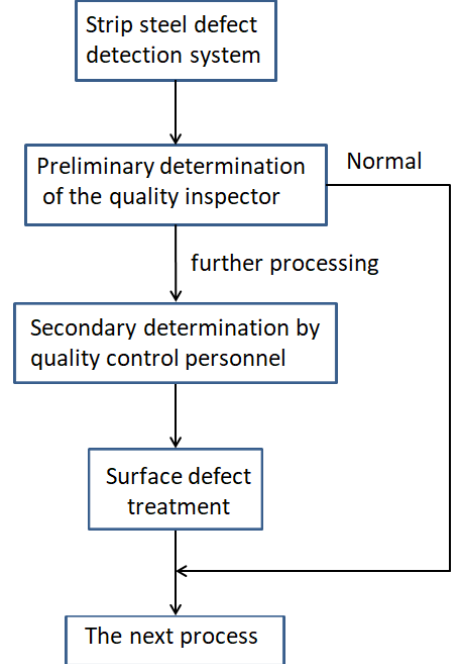
Figure 1. Flow chart of strip defect detection.